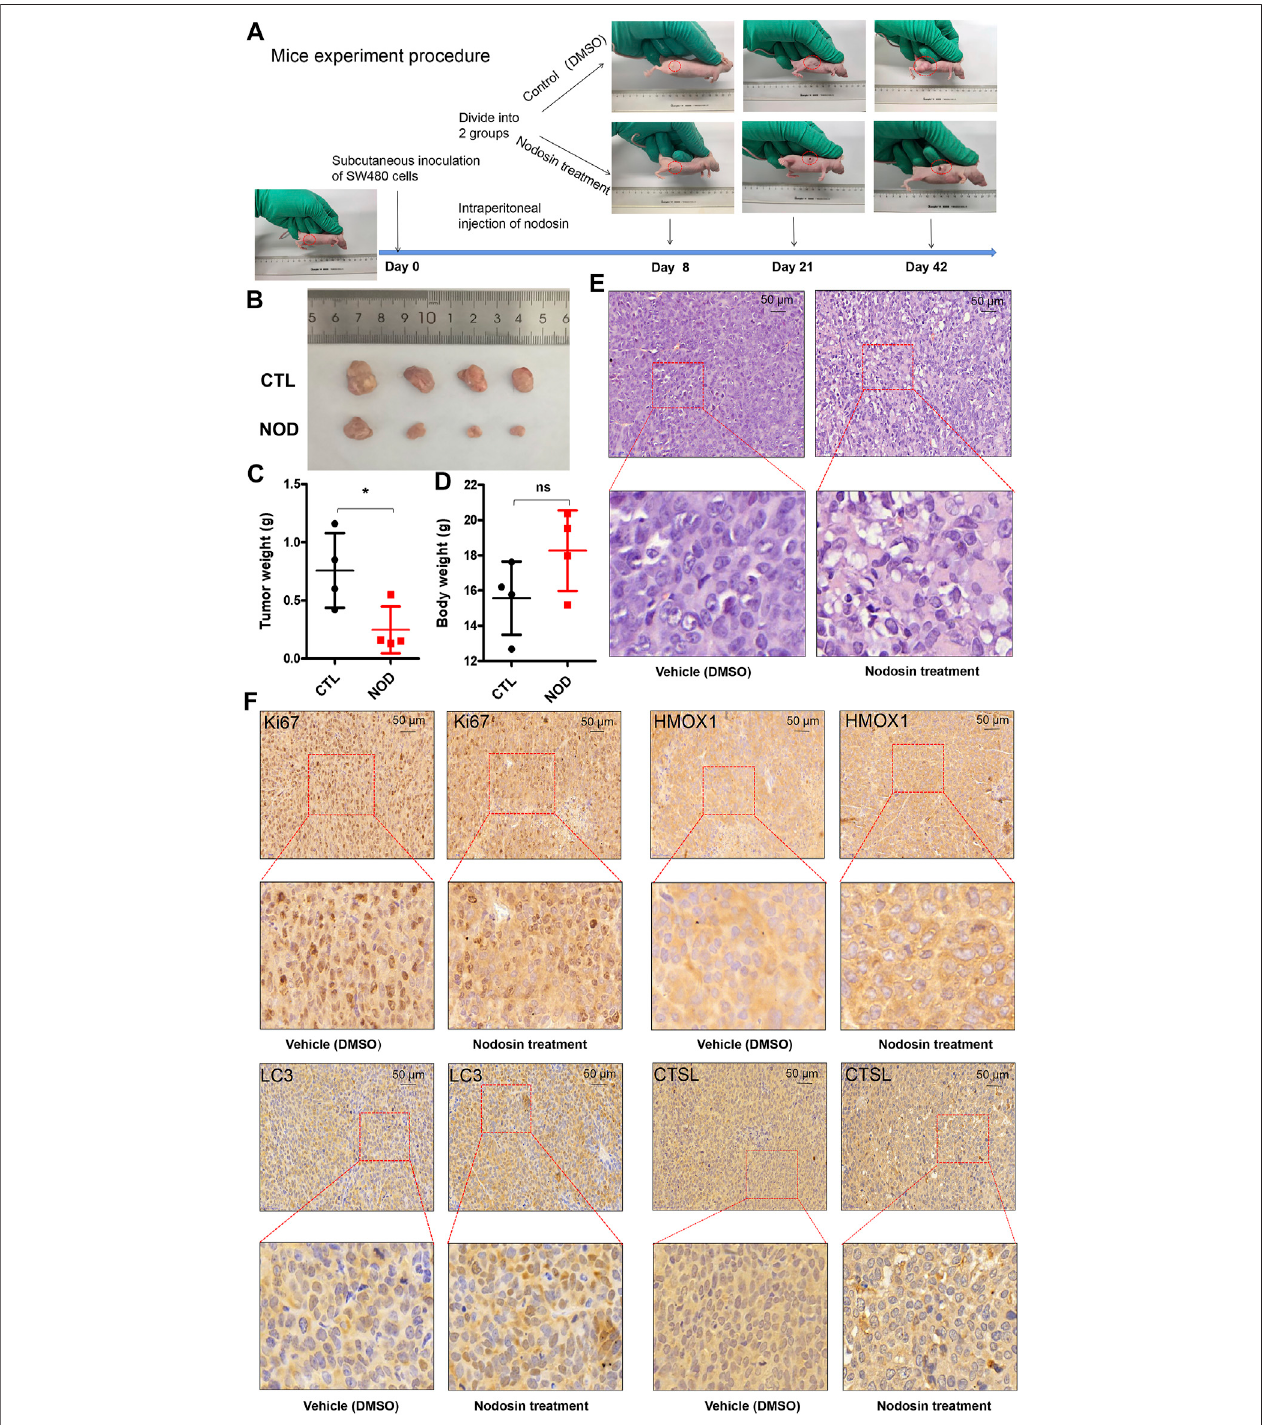
FIGURE 6 | Nodosin supressed the growth of CRC xenograft tumors in nude mice. (A) The whole procedure of the nude mice experiment. (B) The xenograft tumors isolated from nude mice. (C) Tumor weights were compared in nude mice from nodosin treated and control groups. (D) Body weight was compared from nodosintreatedversuscontrolgroups. (E) Thenodosin-treated andcontrolxenografttumorswerestainedwithH&E. (F) IHCwasusedtodetecttheexpressionofKi67, HMOX1, LC3, and CTSL in nodosin-treated and control group, and photographed under microscope.